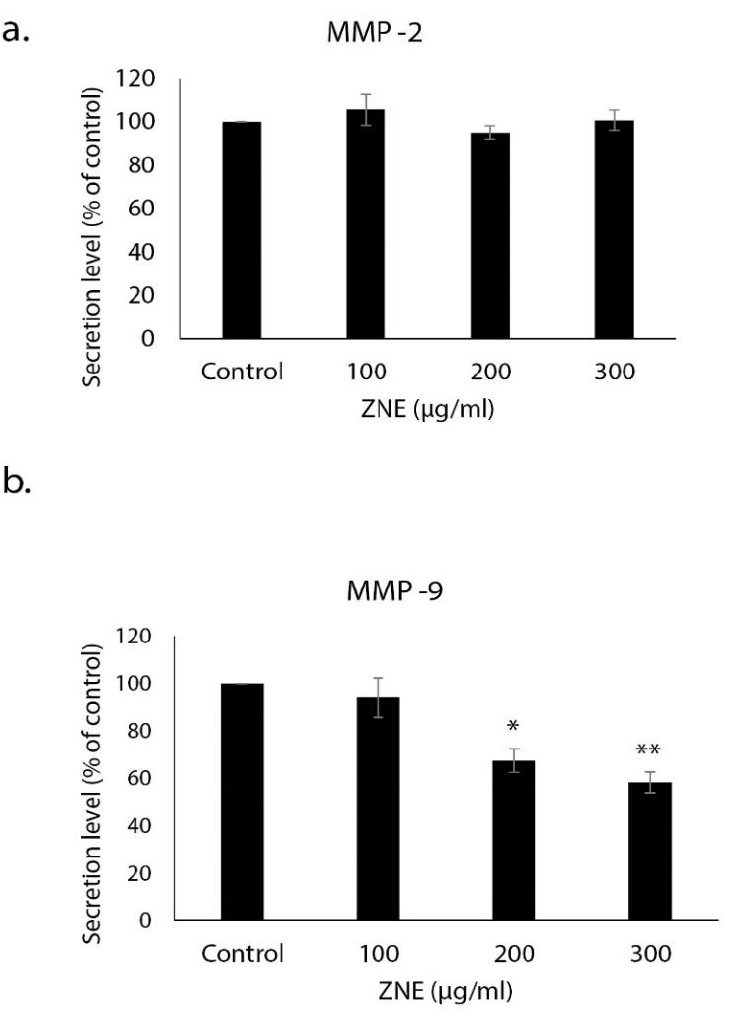
Figure 5. Ziziphus nummularia inhibits MMP-9 secretion. Capan-2 cells were grown in the pres- ence or absence of ZNE. Levels of secreted ( a ) MMP-2 and ( b ) MMP-9 in the conditioned medium of ZNE-treated cells were determined by ELISA. Data represent the mean ± SEM ( n = 3 replicates) from three independent experiments. * denotes p < 0.05 and ** p <0.01.